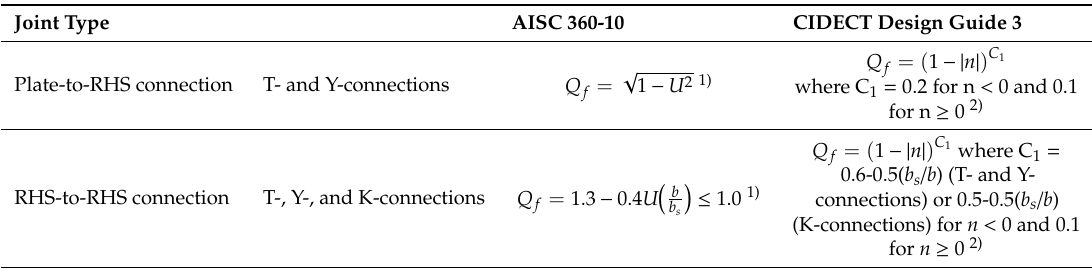
Table 2. Chord member stress functions Q f for RHS truss T-, Y-, and